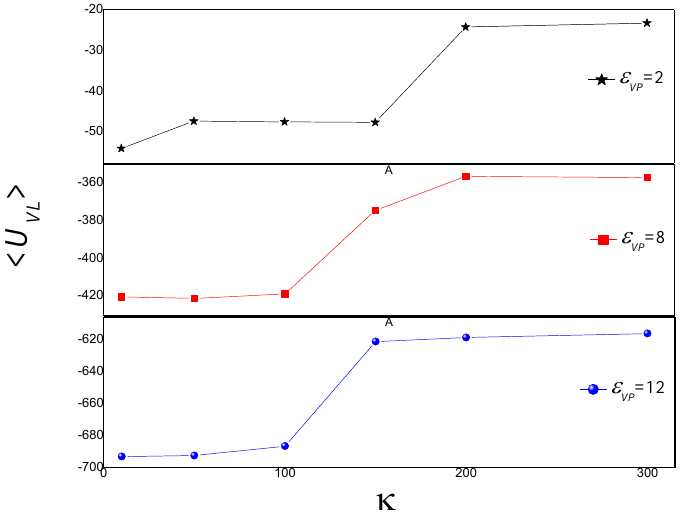
Figure 2. The average attractive energy < U VL > between the semiflexible polymer chain and vesicle versus bending stiffness κ for ε VP = 2, 8, and 12.